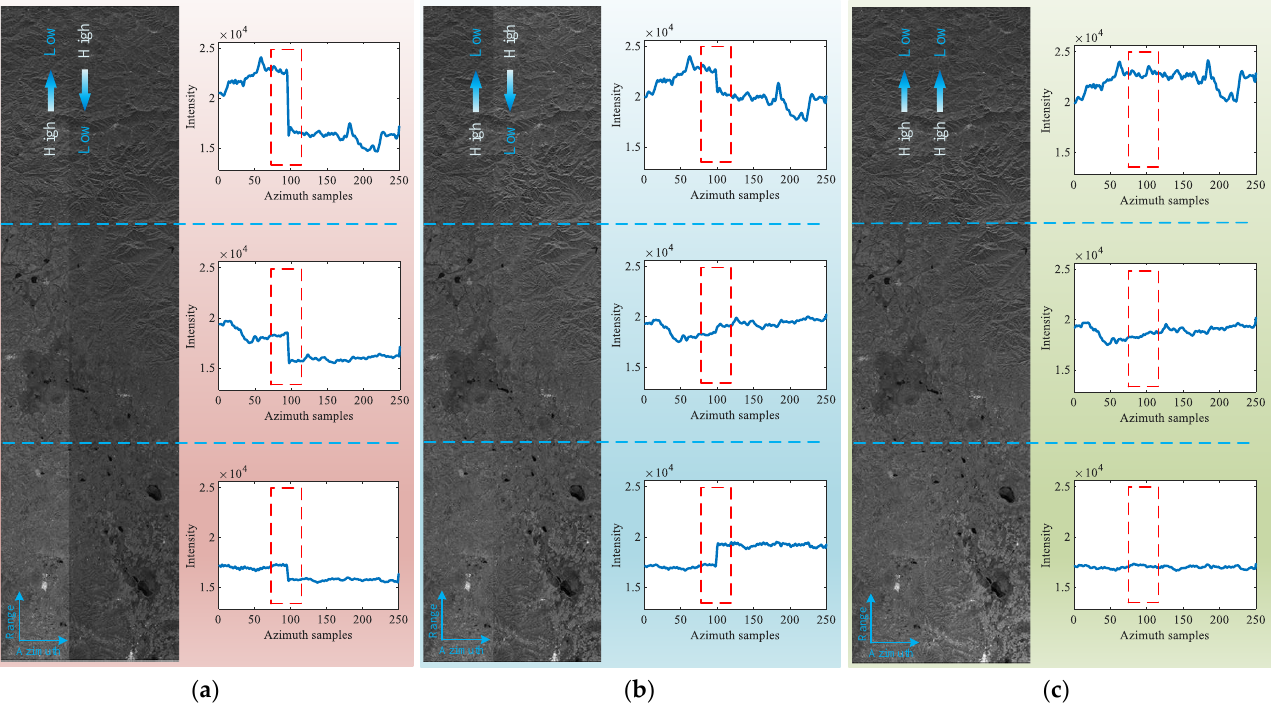
Figure 8. Image preprocessing experiment: ( a ) result without preprocessing; ( b ) result with the classic Wallis filter (the existing method of traditional process); ( c ) result with the improved Wallis filter (the method we proposed).